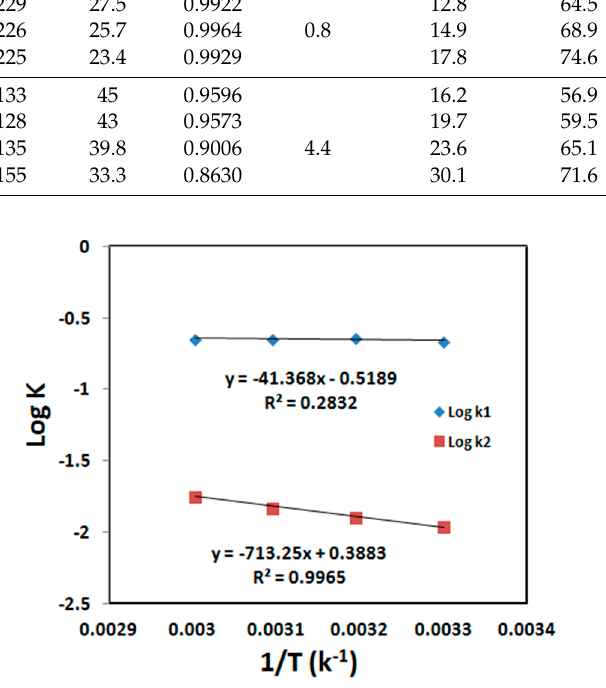
Figure 13. Variation of log k 1 and log k 2 with 1 / T for sorption of U(VI) onto HQ-bentonite (Arrhenius plot).